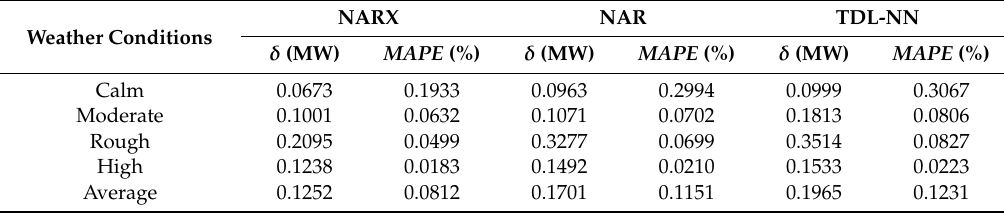
Figure 10. ( a ) The proposed model comparison for the SOTLF for 31 days ahead forecasting error percentage, and ( b ) error variance in MW. Table 3. Comparison of one-month DP load forecasting in di ff erent weather